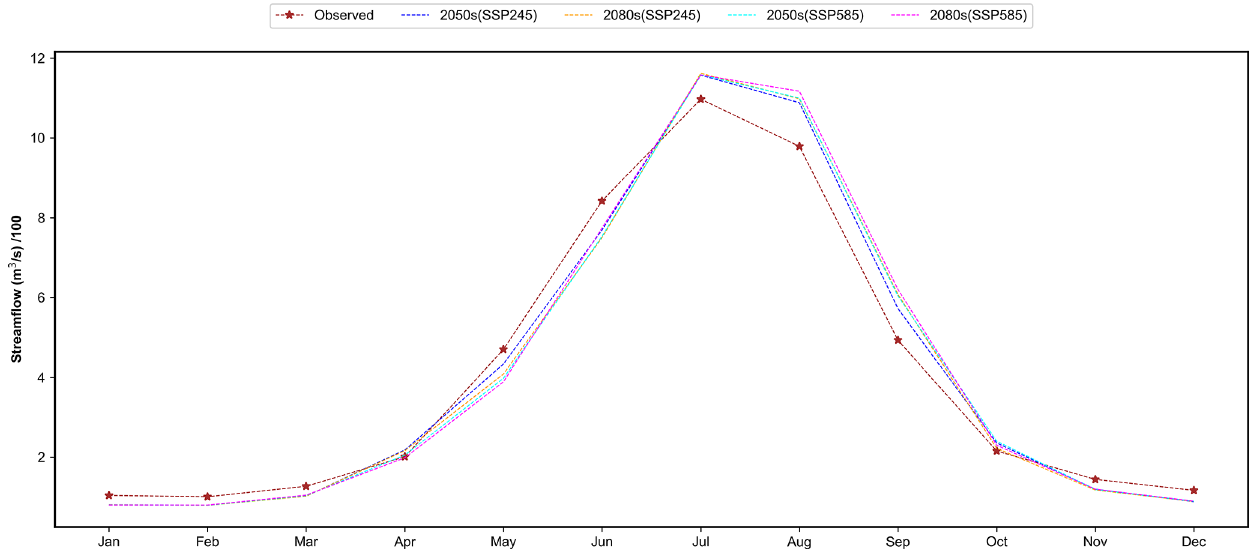
Figure 17. Comparison of monthly observed (1979–2009) and projected discharge of the multimodel ensembles for the 2050s and 2080s under the SSP245 and SSP585